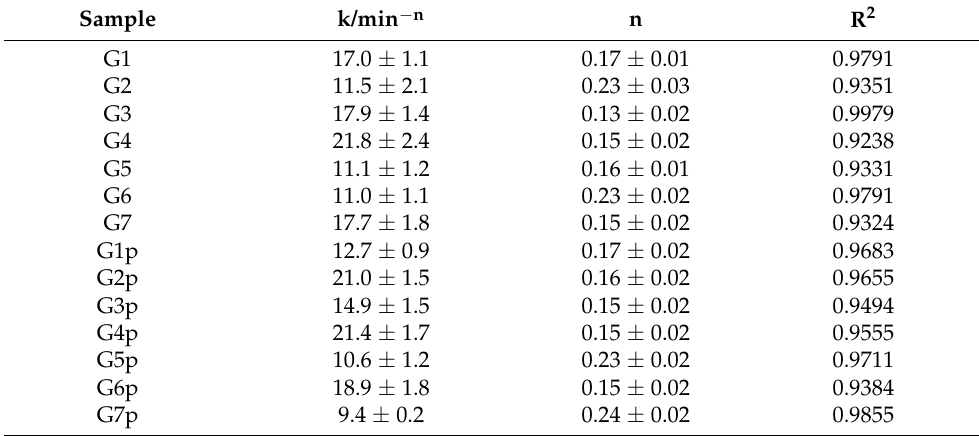
Table 3. Fitting parameters for ciprofloxacin release from granules (k—constant; n—parameter of release mechanism; R 2 —correlation